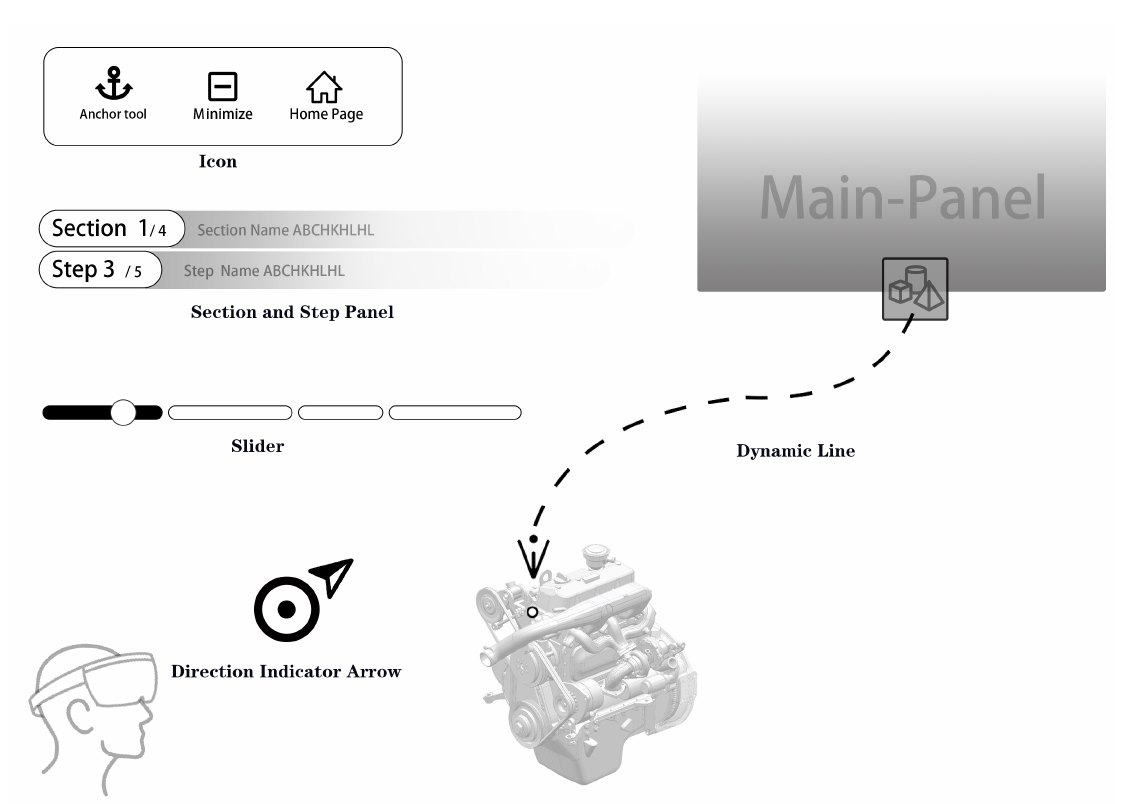
Figure 8. Sketch of navigational